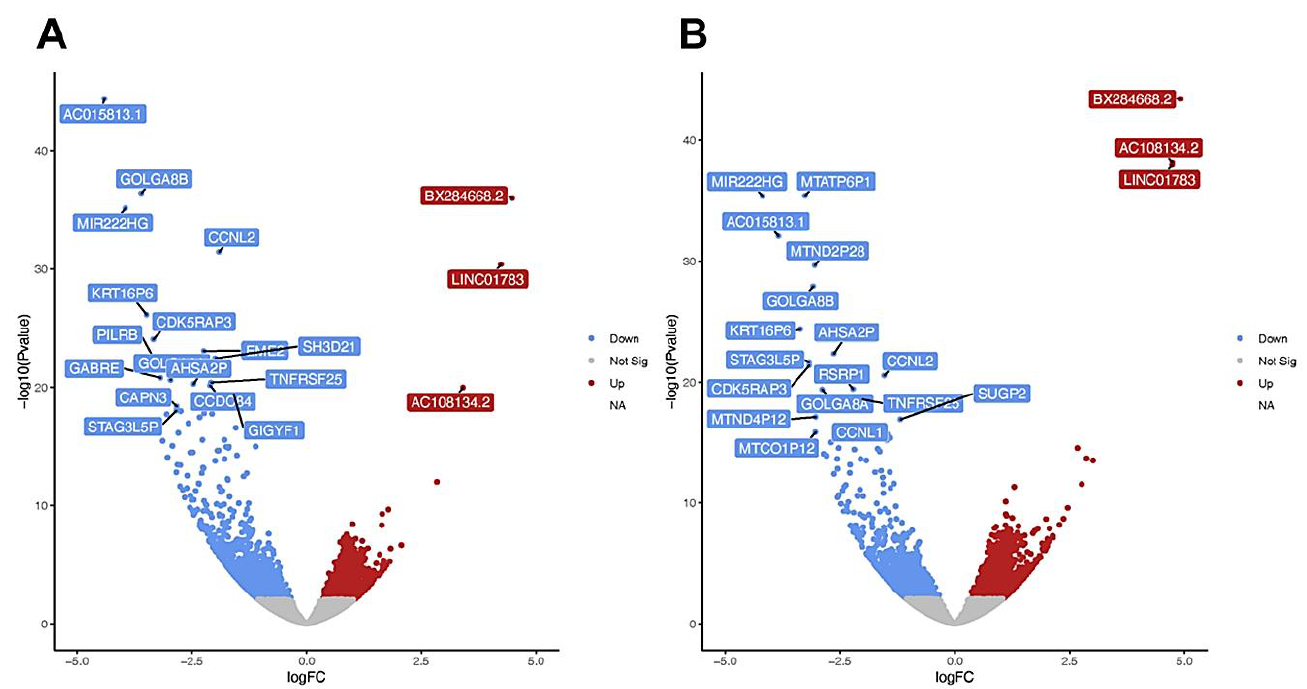
Figure 1. Volcano Plots of transcriptome analysis of keratinocytes treated with 200 mM NaCl for 6 h ( A ) and 12 h ( B ) (each n = 3 ) . Each point represents an individual gene. The y-axis shows – log 10 ( p -value) for the associations per gene, and the x-axis shows the effect, log 2 FC. Grey represents non-significant genes ( p > 0.05), blue downregulated, and red upregulated.